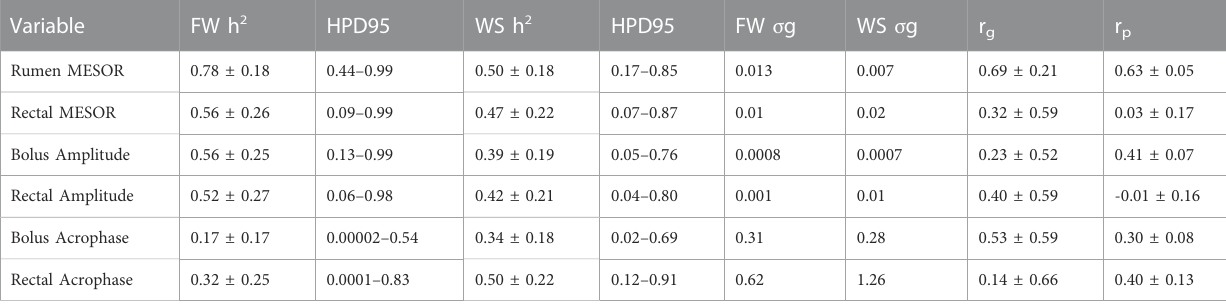
TABLE 4 Heritability (±PSD) and some genetic parameters for circadian core body temperature